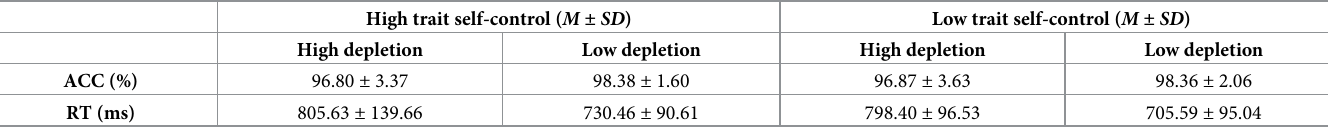
Table 6. Descriptive statistics of accuracy and response time during the Stroop task.